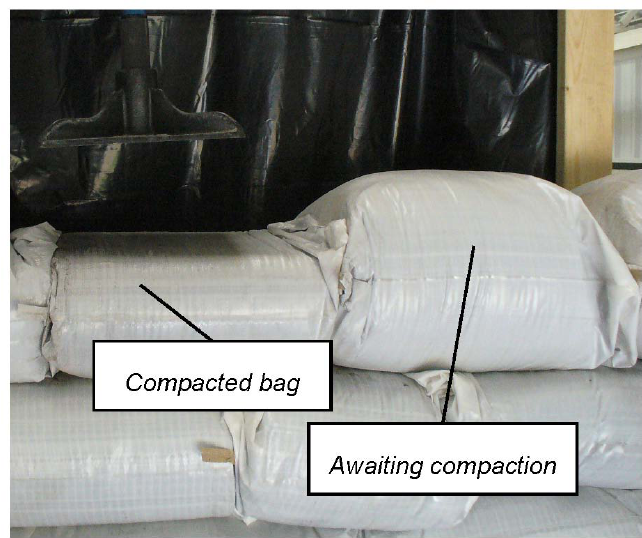
Figure 2. Earthbag compaction during wall